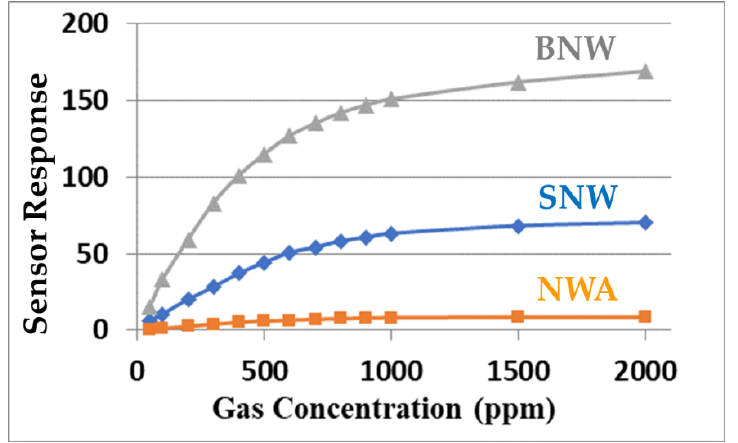
Figure 6. Sensor response as a function of the acetone concentration of the three sensors.